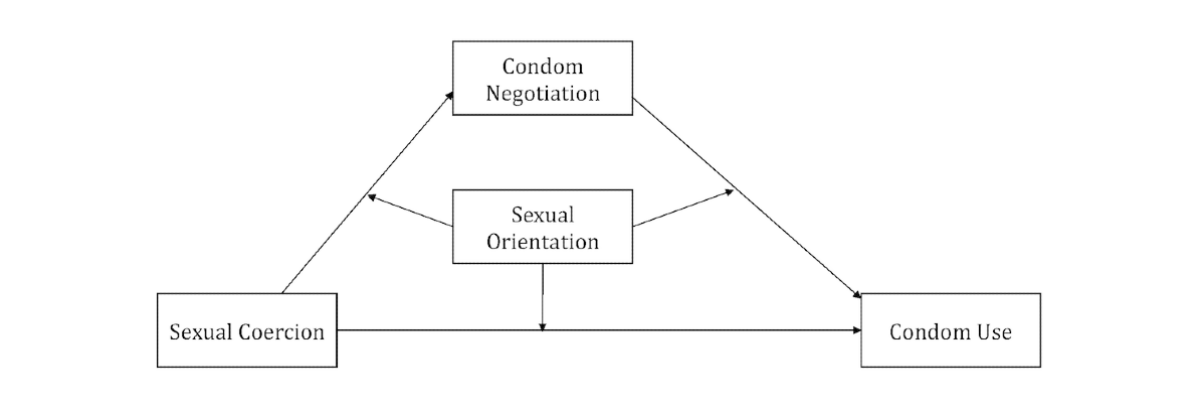
Figure 1. Proposed moderated mediation